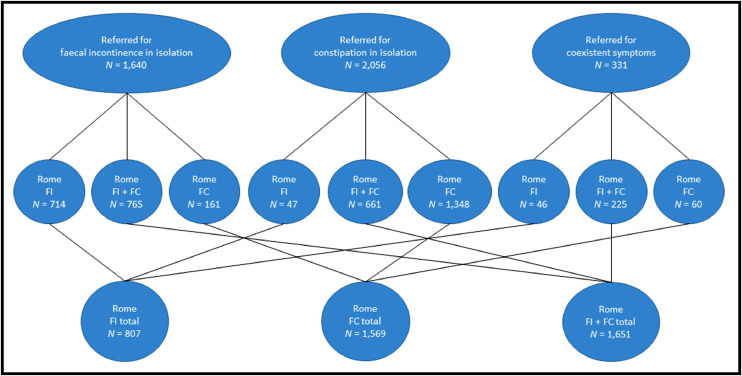
Relationships between primary reason for referral (upper three panels) and Rome reclassification according to patient-reported symptoms (middle and lower panels). FI = faecal incontinence; FC = functional constipation.